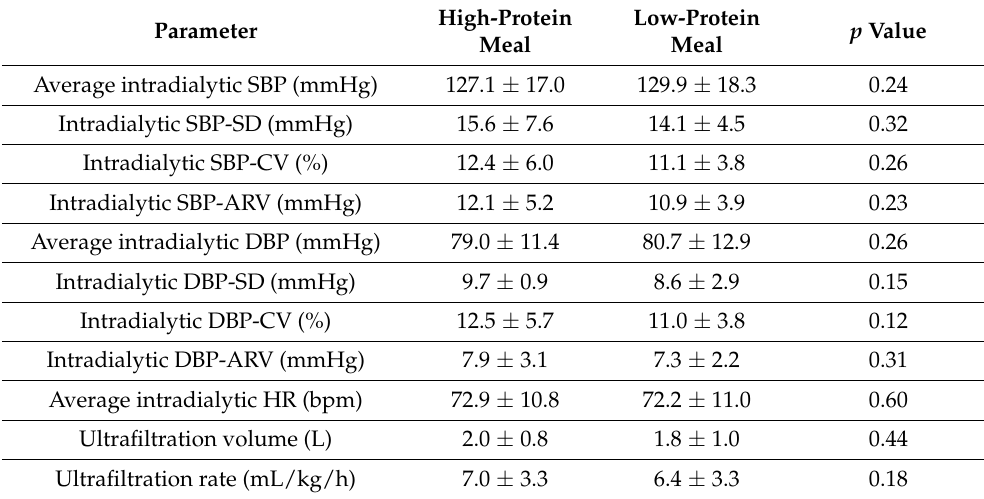
Table 4. Comparison of intradialytic BP variability parameters between phases A and B of the study. Parameter